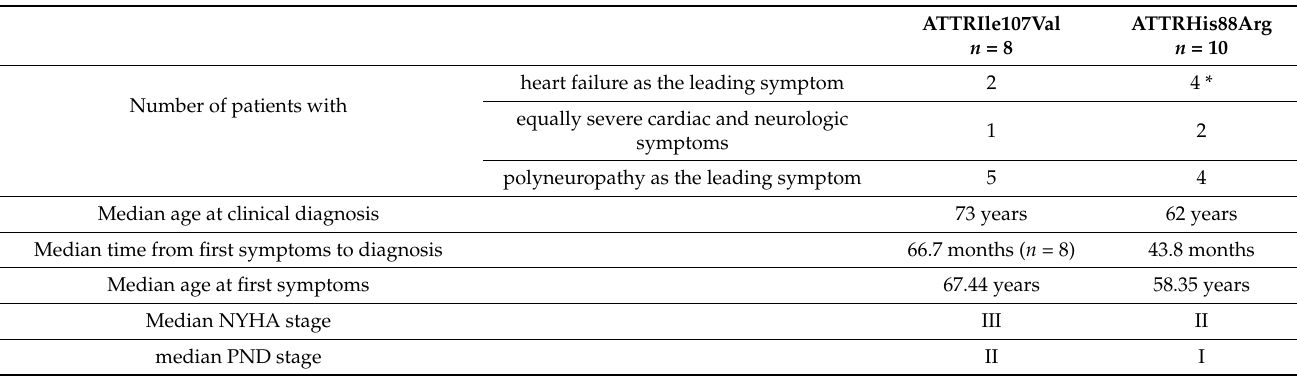
Table 2. Genotype–phenotype correlation in symptomatic Hungarian ATTRv patients with the two common mutations (ATTRHis88Arg and